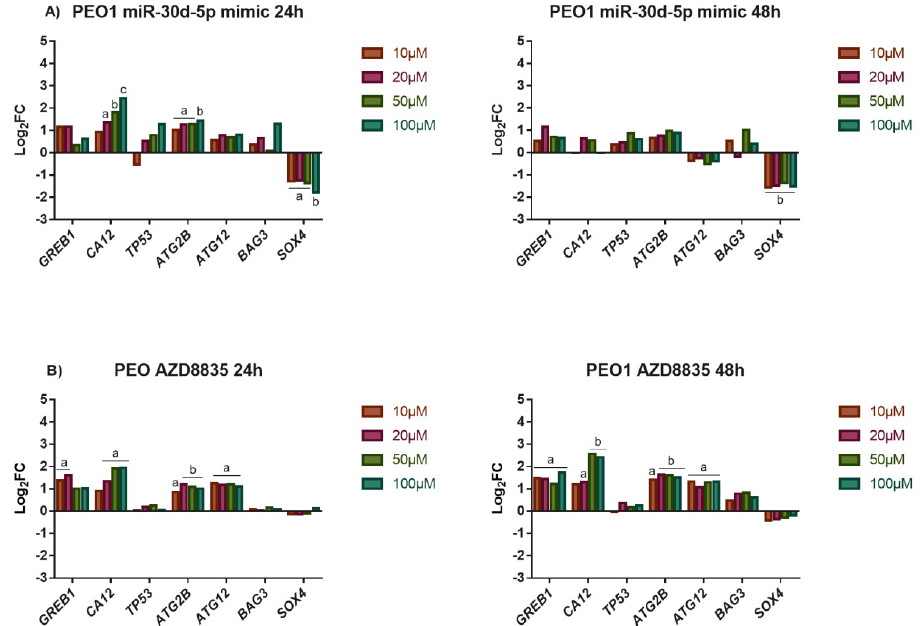
Figure 7. Study the effect of high-dose E2 exposure on gene expression in the presence of miR-30d-5p mimic or AZD8835. Log 2 FC values of selected genes were determined in response to E2 treatment in the PEO1 cell line in the presence of 50 nM miR-30d-5p mimic ( A ) or 100 nM AZD8835 ( B ). Total RNA was isolated from the cells at 24 h and 48 h after E2 treatment. Significance was determined between the ∆ CT values of the treated and non-treated samples. a: p < 0.05; b: p < 0.01; c: p < 0.001.